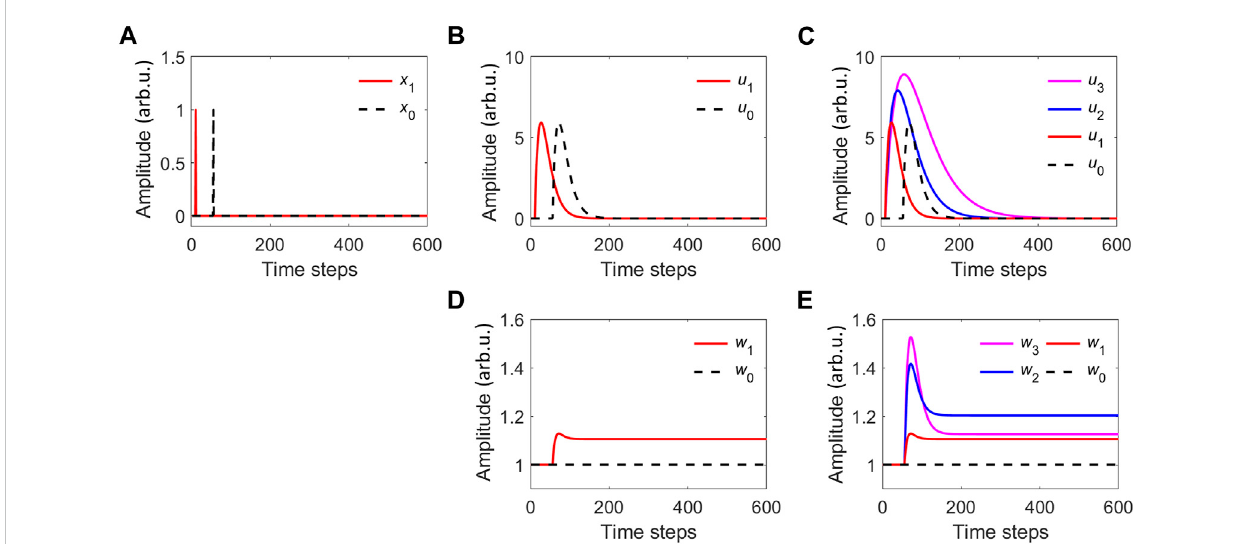
FIGURE 2 (A) Two delta-function raw inputs x 1 and x 0 with a time difference of T = 45 steps. (B) Their corresponding fi ltered activation signals ( u 1 and u 0 ). (C) Thecorresponding fi lteredactivationsignalswhenconsideringthreedifferent fi ltersforthestimulussignal x 1 .The fi lterparametersare: Q =0.51and c =1/ (1+0.5 ( i − 1)), f =0.01/ i for the three activation inputs u 1 , u 2 and u 3 , and c =1, f =0.01 for u 0 . (D) The weights for the fi ltered activation signal of case (B) . (E) The weights for the fi ltered activation signal of case (C)